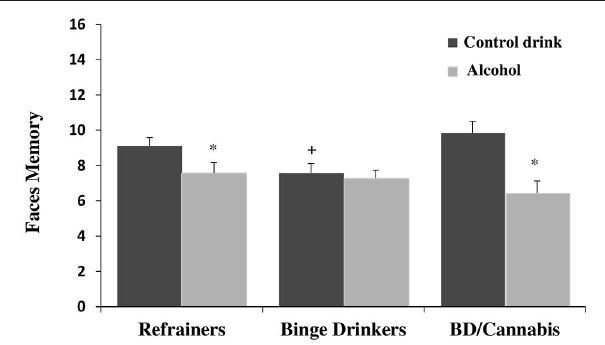
FIGURE 1 | Performance in faces memory task (mean + SEM) in men. * p < 0.05 vs. Control drink. + p < 0.05 vs. Refrainers-Control drink (R-Co) and BD/Cannabis-Control drink